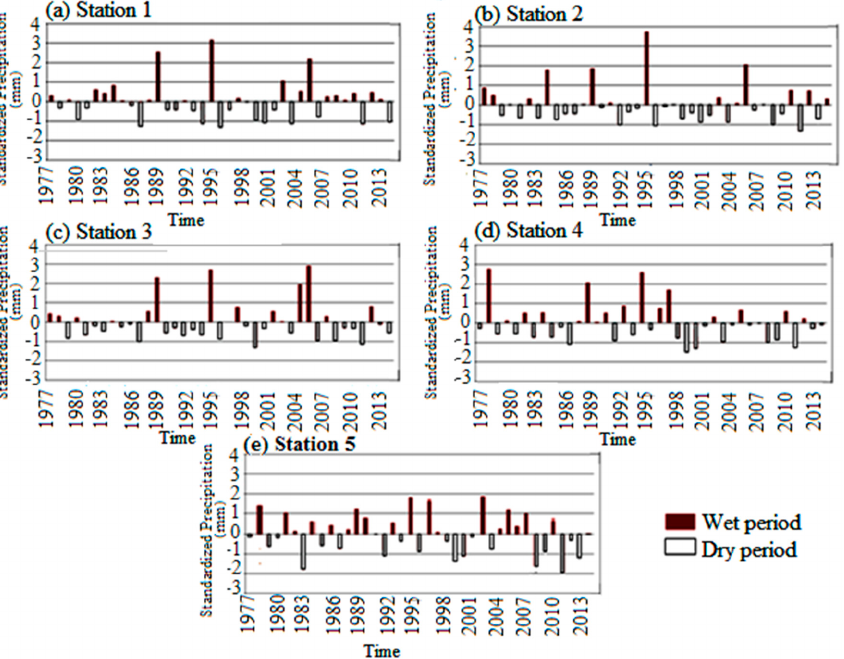
Figure 3. Standardized precipitation ratio of rainfall in the 5 selected representative stations